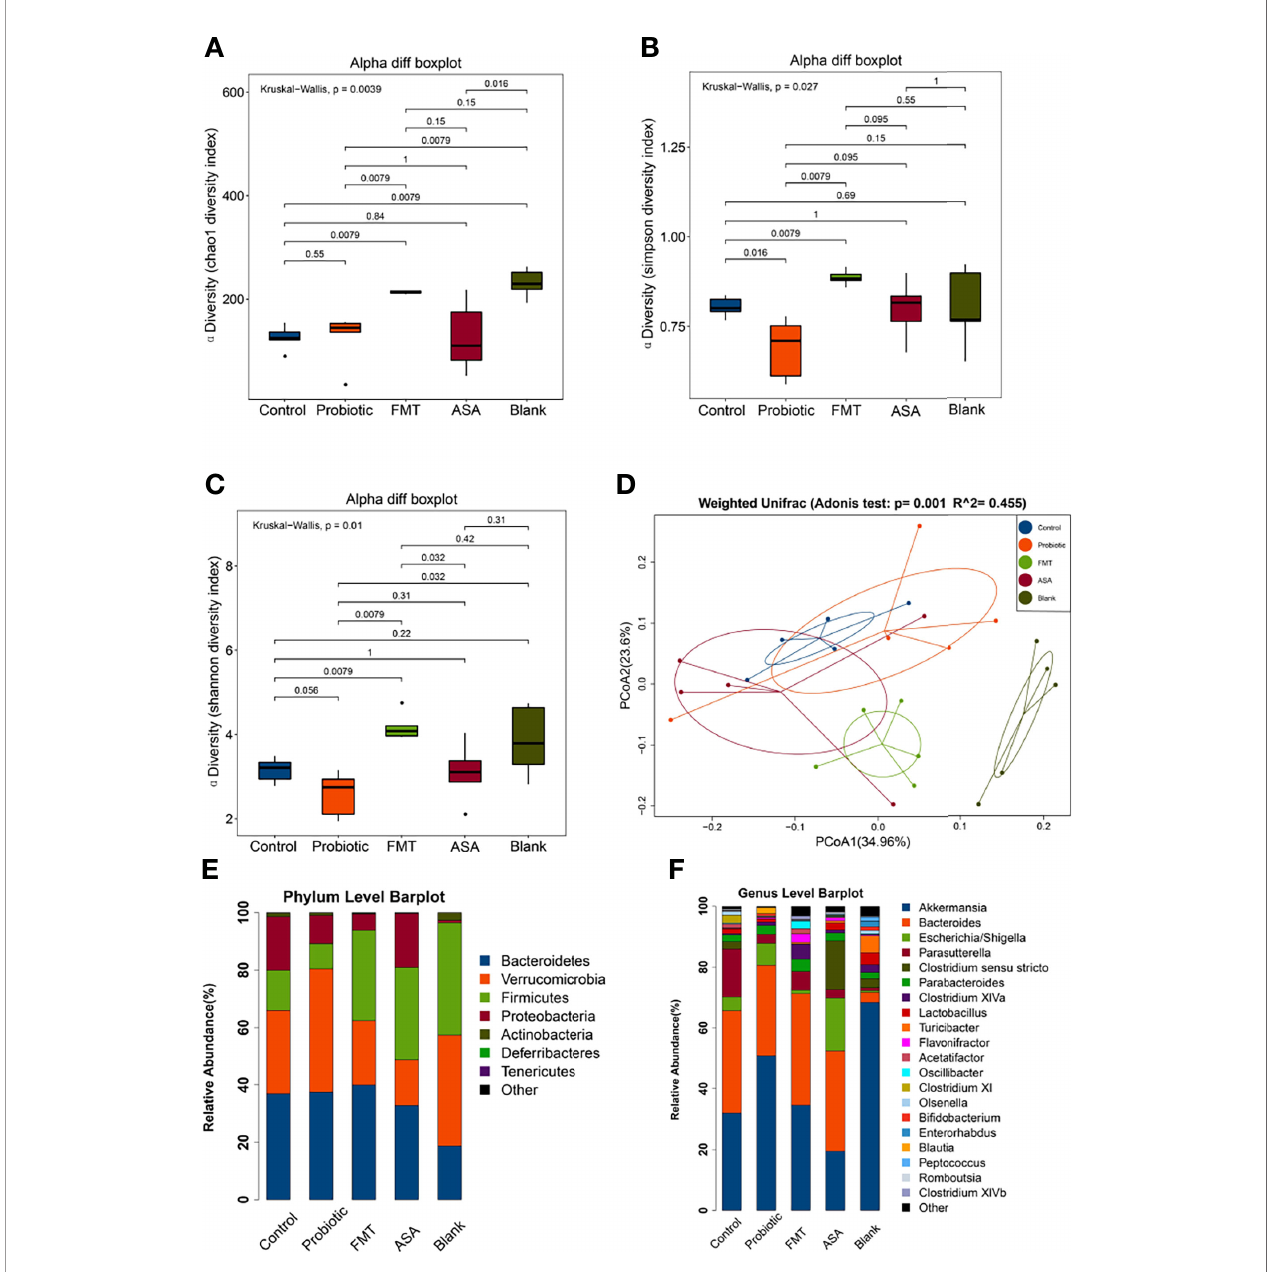
FIGURE 3 | Diversity and composition of gut microbiota. (A – C) Alpha diversity was evaluated by the Chao1, Shannon, Simpson index among blank mice, and DSS- induced colitis mice treated with PBS, healthy mice donor FMT, 5-ASA, or the probiotic cocktail. (D) Weighted UniFrac PCoA analysis was utilized to distinguish bacterial clustering. The component proportion of the microbiome at the phylum (E) and genus level (F) among groups was shown. The relative abundance of genera difference was identi fi ed via the Wilcoxon rank-sum test. DSS, dextran sodium sulfate; PBS, phosphate buffered saline; FMT, fecal microbiota transplantation; 5-ASA, 5-aminosalicylic acid; PCoA, principal coordinate